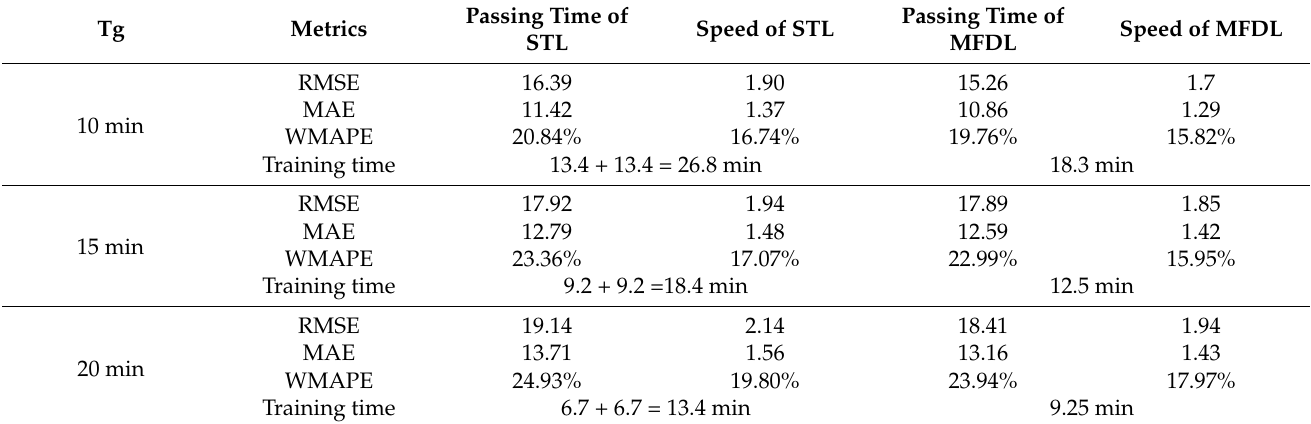
Table 5. The comparison of signal-task prediction and multi-task